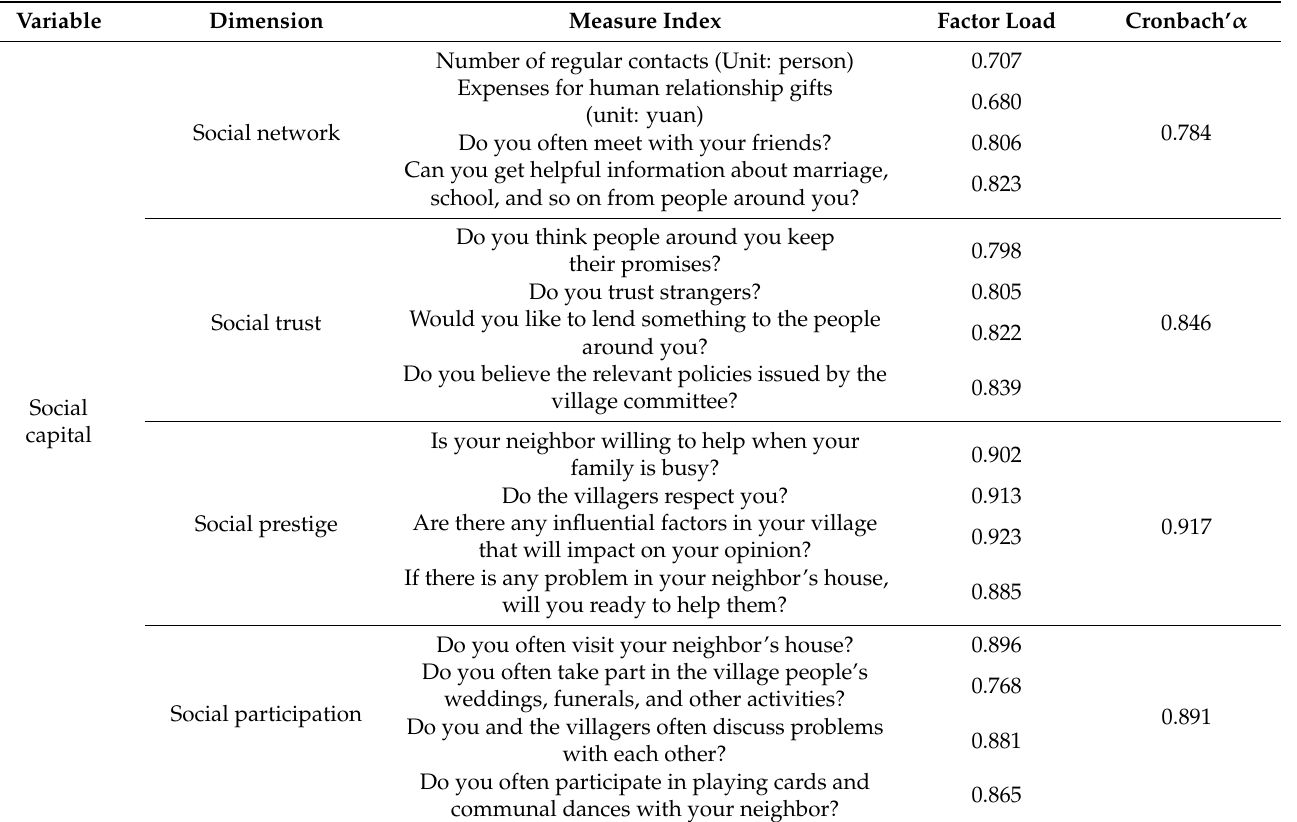
Table A1. Social capital measurement indicators and reliability and validity tests. Variable Dimension Measure Index Factor Load Cronbach’ α